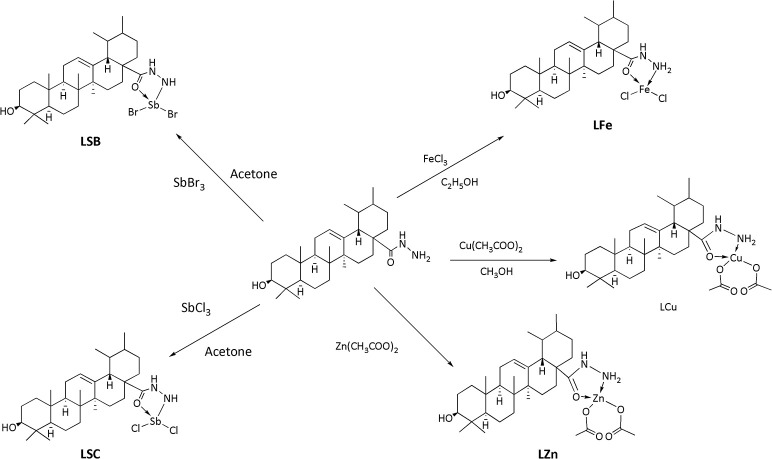
Synthesis of Cu, Fe, Zn and Sb complexes.